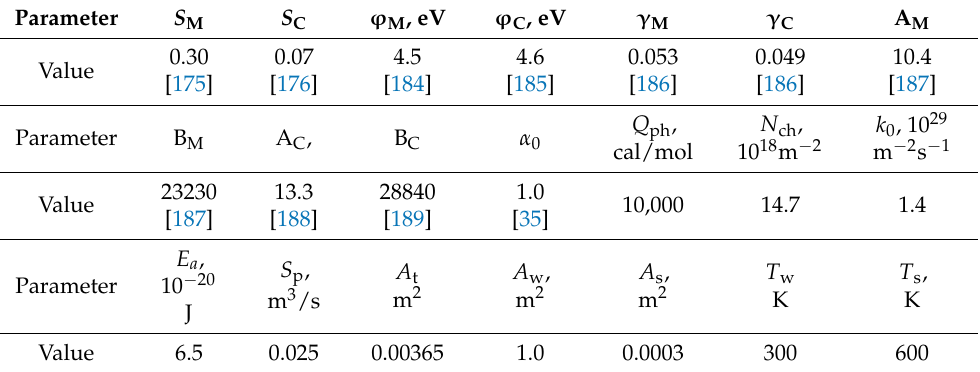
Table 3. Parameters of the model for reactive sputtering of a hot titanium target in Ar + N 2